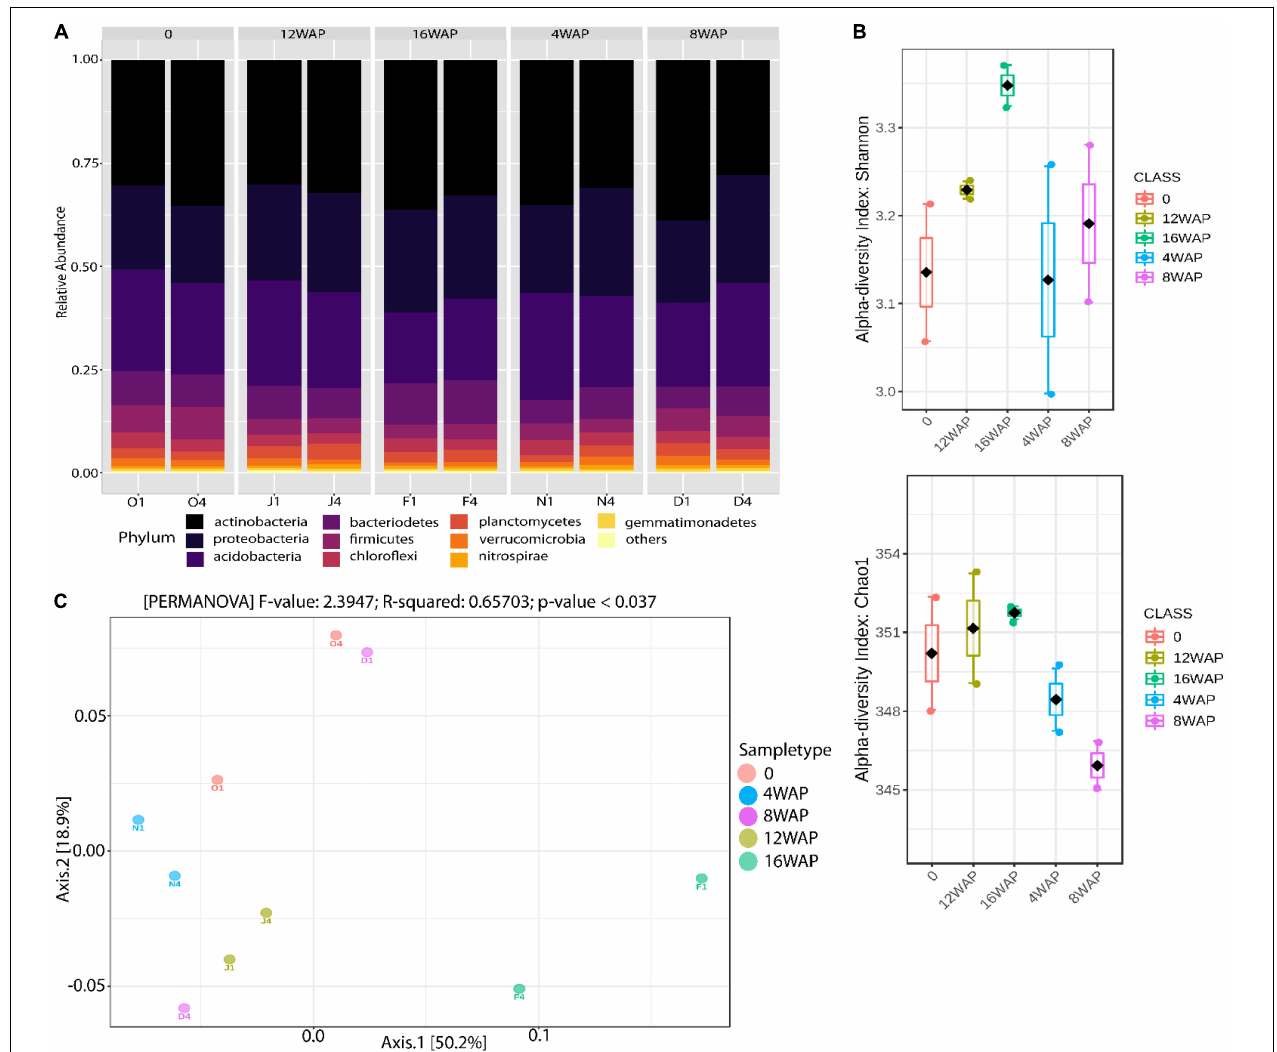
FIGURE 1 | Rhizobacterial community assembly of Bambara groundnut plants during their growth cycle. (A) Taxonomic distribution of bacterial communities in the rhizosphere soils at different growth stages and in the bulk soil. (B) Alpha diversity of 16S rRNA rhizosphere bacterial sequences of Bambara groundnut in the rhizosphere soils at different growth stages. Shannon and Chao 1 diversity indices were calculated with Total Sum Scaling (TSS) normalized counts. (C) Principal Coordinate Analysis (PCoA) of 16S rRNA diversity in the rhizosphere of the Bambara groundnut growth stages and the bulk soil.